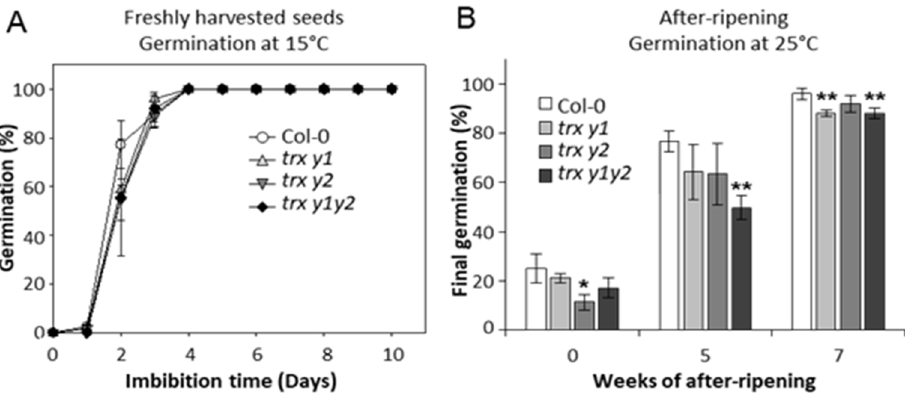
Figure 1. Germination of Trxs y mutant seeds at harvest and during after-ripening. Germination assays of Col-0 and Trxs y mutant seeds were performed in the dark with water-imbibed seeds. ( A ) Germination rates at 15 °C, directly after harvest. ( B ) Final germination percentage at 25 °C, after 10 days of imbibition of freshly harvested seeds, or after 5- and 7-weeks dry storage (after-ripening treatment). Means ± SD from triplicate experiments (3 independent seed batches) are shown. Significance levels: * p < 0.05, ** p < 0.01 compared to Col-0 by Student’s t -test.